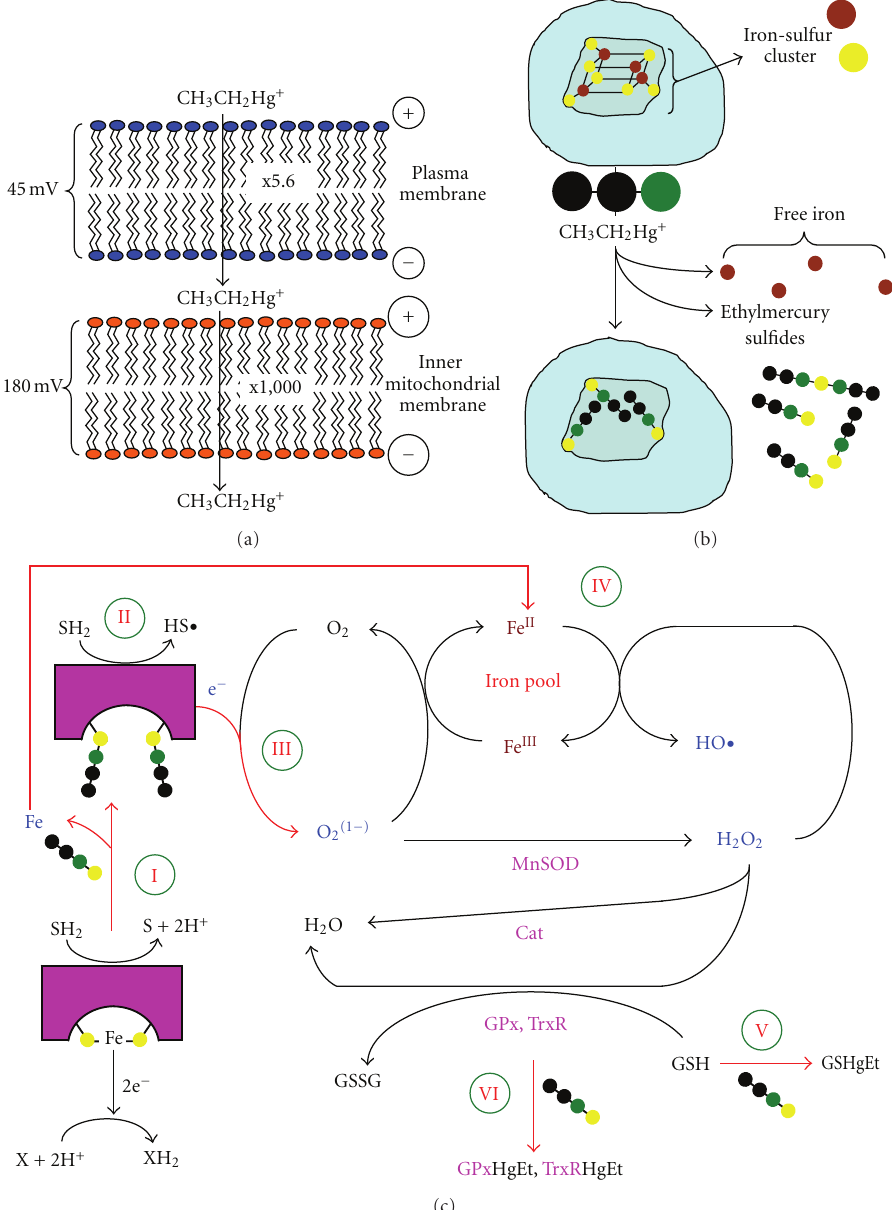
Figure 7: Proposed mechanism for the toxicity of organomercury. (a) As a lipophilic cation, ethylmercury will become concentrated inside astrocytes, following the plasma membrane potential of 45 mV [37], by a factor of 5.6 fold, and cytosolic ethlymercury will partition into the mitochondria by a factor of 1,000 fold, its accumulation driven by the approximate 180 mV mitochondrial membrane potential [25]. (b) Inside the mitochondria ethylmercury will react and cap thiols/selenols, including the cysteine residues of iron-sulfur centers. The formation of ethylmercuricthiol adducts will not only cause enzyme inhibition, but also increase the levels of free iron inside the mitochondria. (c) The release of iron catalyzes Fenton/Haber-Weiss chemistry leading to the formation of the highly oxidizing HO • . HO • has multiple targets, including sensors of the permeability transition complex and also mtDNA. High levels of HO • cause Mitoposis, leading to cytochrome c release from the mitochondria and the initiation of